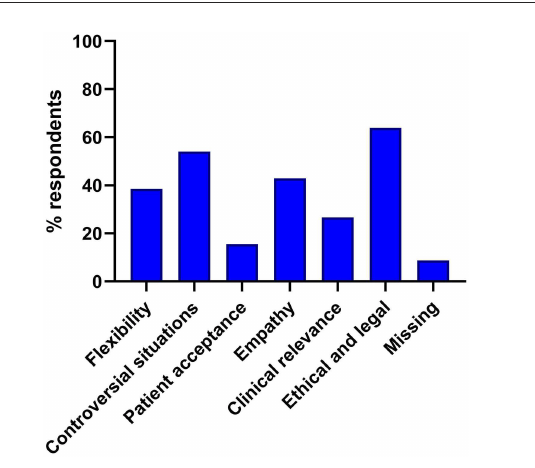
Perceived disadvantages of the use of artificial intelligence in medicine. Responses were selected from a list of set choices, multiple selections were